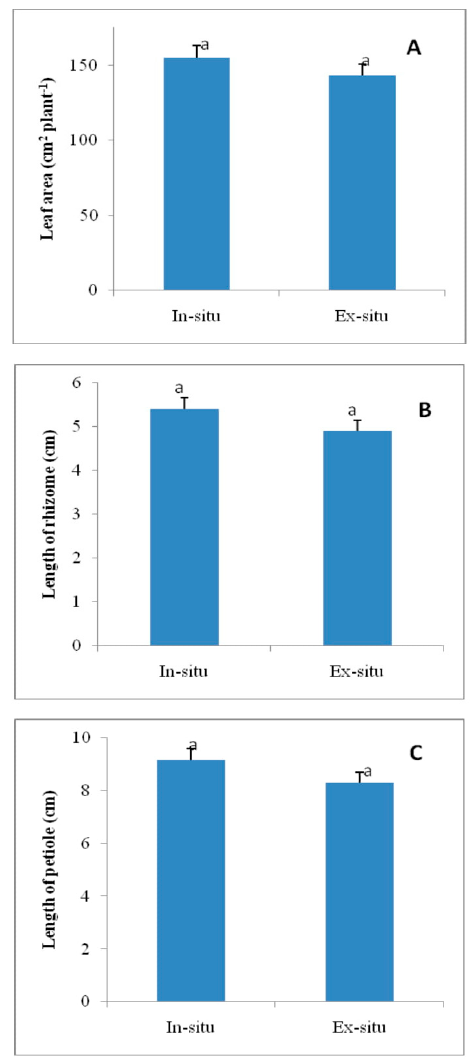
Figure 6. Area ( A ), length of rhizome ( B ), and length of petiole ( C ) in in-situ and ex-situ grown plants of Valeriana wallichii . Data are presented as treatments mean ± SE ( n = 5). SE = standard error; n = number of samples. The mean difference of in-situ from ex-situ was considered statistically significant at p < 0.05 (using Student’s t -test). Data followed by the same letter are not significantly different.